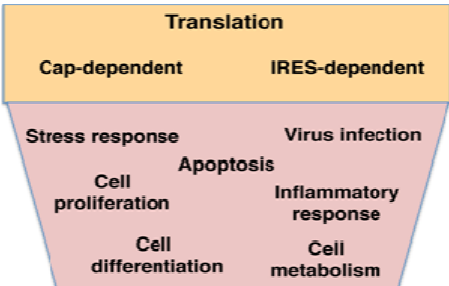
Figure 2. RNA-binding proteins control translation efficiency of mRNAs initiating protein synthesis by the conventional cap-dependent, or the alternative internal ribosome entry site (IRES)-dependent, mechanisms ( orange box ), impacting on cellular processes in cells undergoing normal growth as well as in response to environmental stresses ( pink box